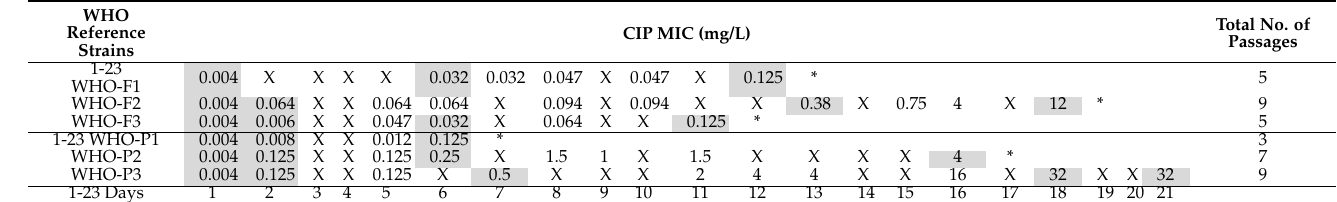
Table 1. Evolution of ciprofloxacin resistance over time. The isolates that were subjected to WGS are colored in grey. Asterisk denotes bacterial cell death. X: data not recorded. Asterisk denotes bacterial cell